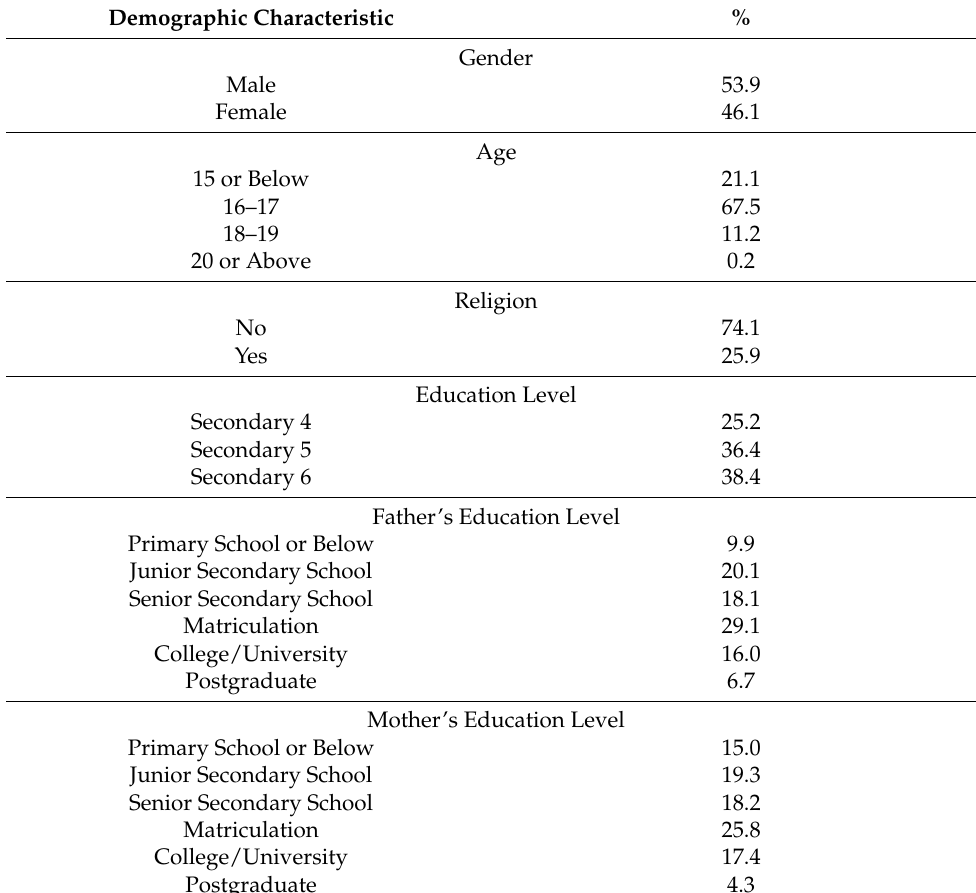
Table 1. Demographic Characteristics as a Percentage of the Sample ( n =